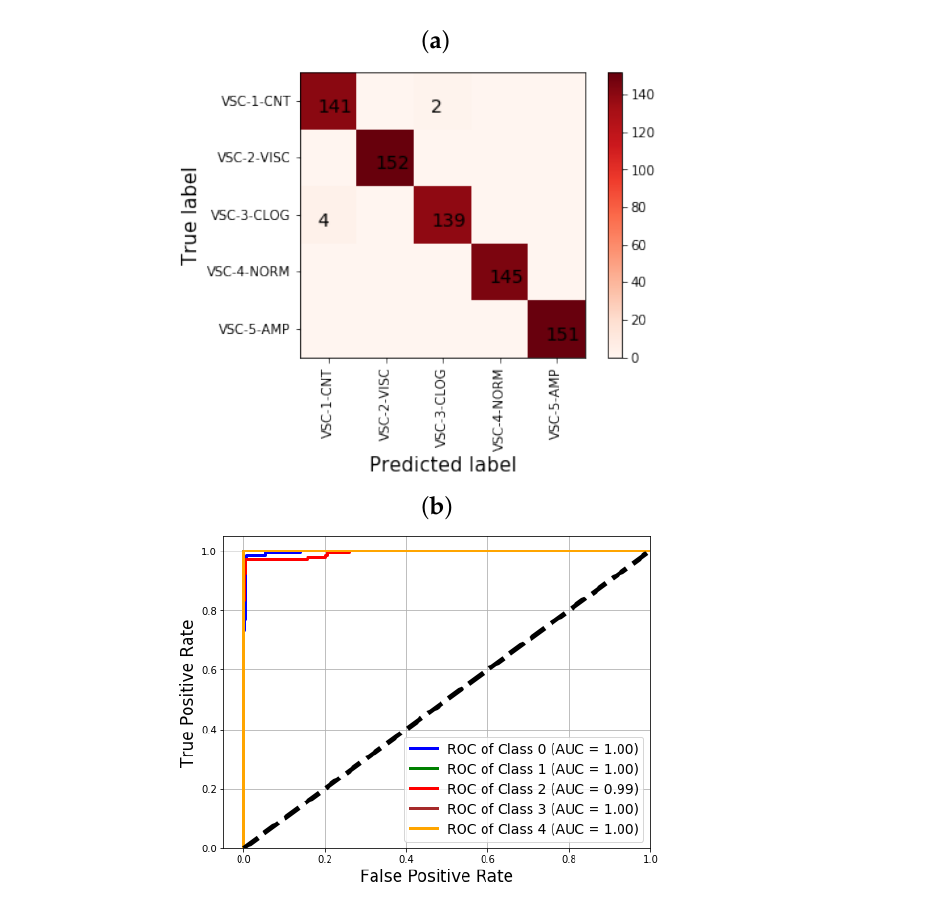
Figure 8. SVM-RBF with RFE performance results showing ( a ) confusion matrix and ( b ) ROC curve. Figure 9 shows the comparison in FDI performance of the classifiers where the blue dotted lines with squared intersects represent their respective test accuracies while the red dotted lines with round intersects represent their respective training accuracies. The purple dotted lines with triangle intersects represent their respective training times (in percentage of the total training time of the whole classifier).